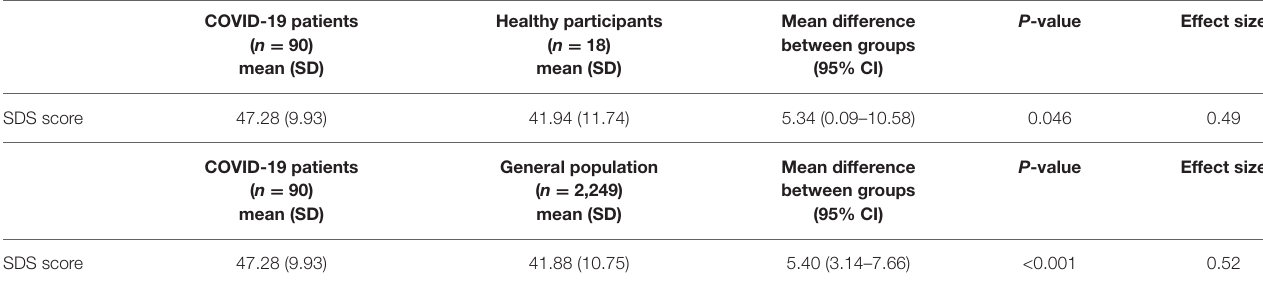
TABLE 7 | Average score of the Self-rating depression scale (SDS) reported by COVID-19 survivors, healthy participants, and the general